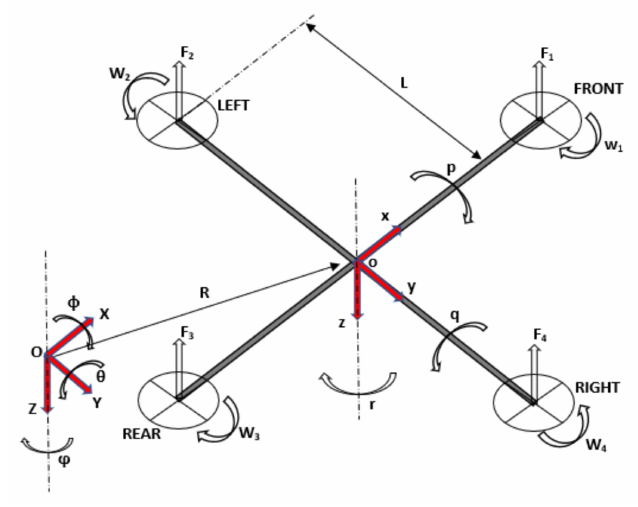
Figure 2. Schematic representation of the quadrotor configuration of